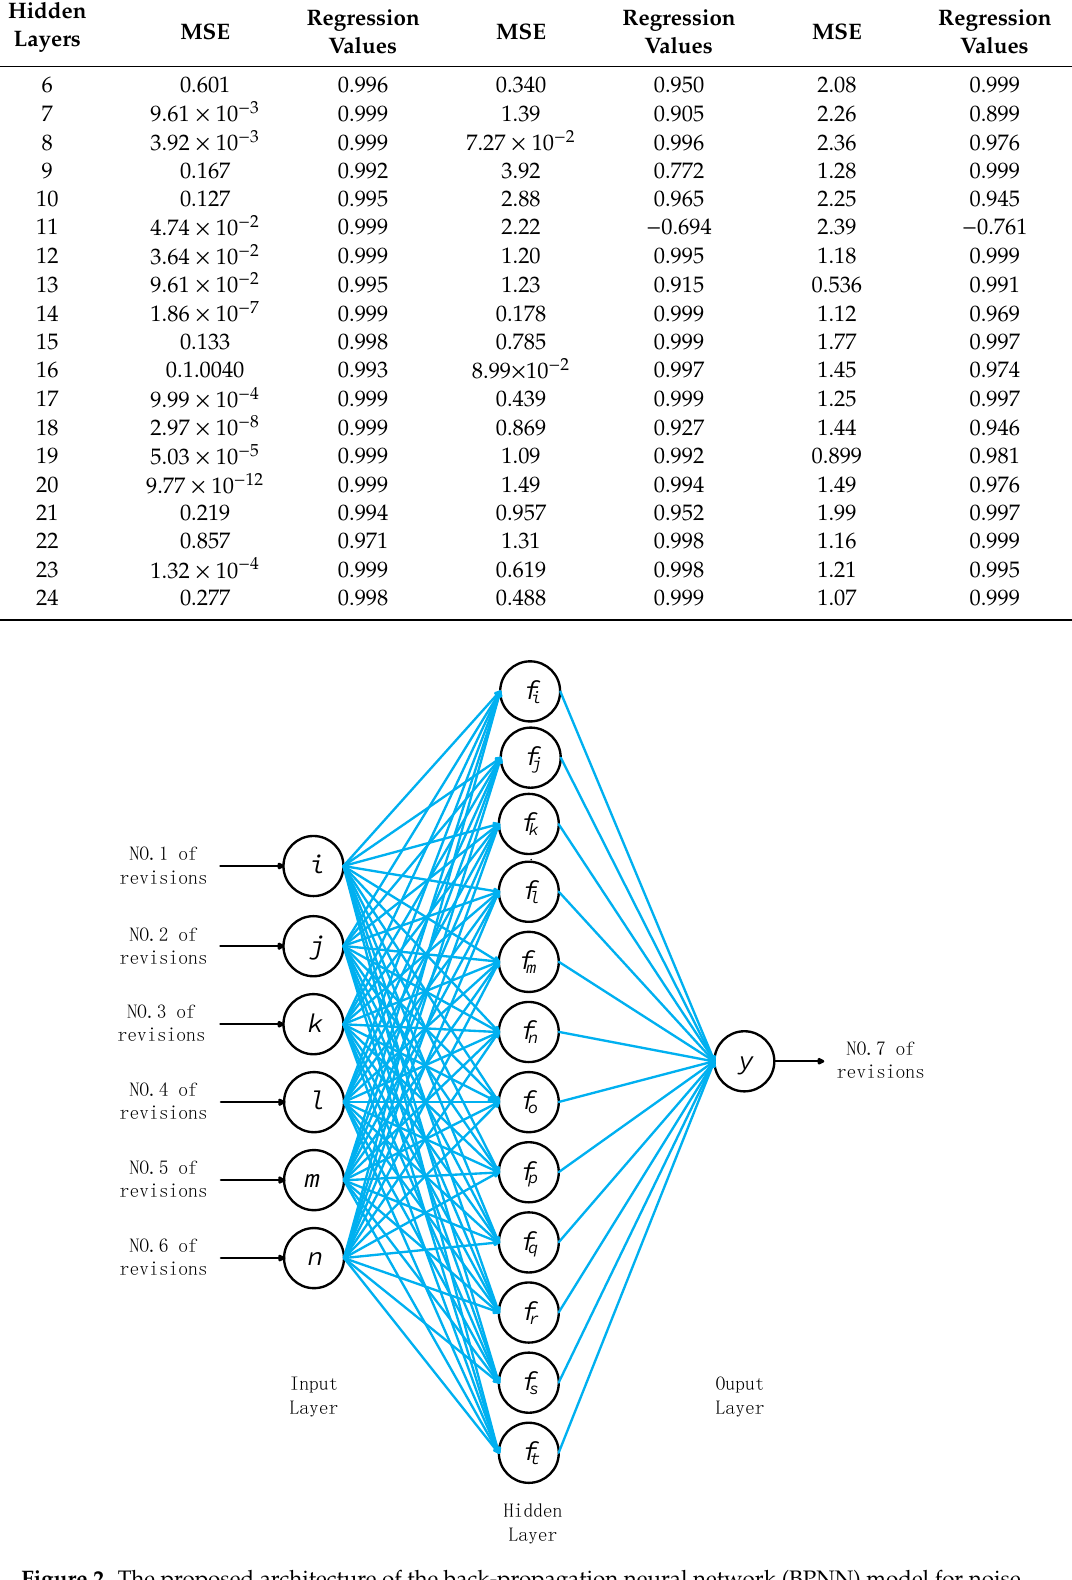
Table 2. Mean squared errors (MSE) and regression values with a di ff erent number of hidden layers. Number of Hidden